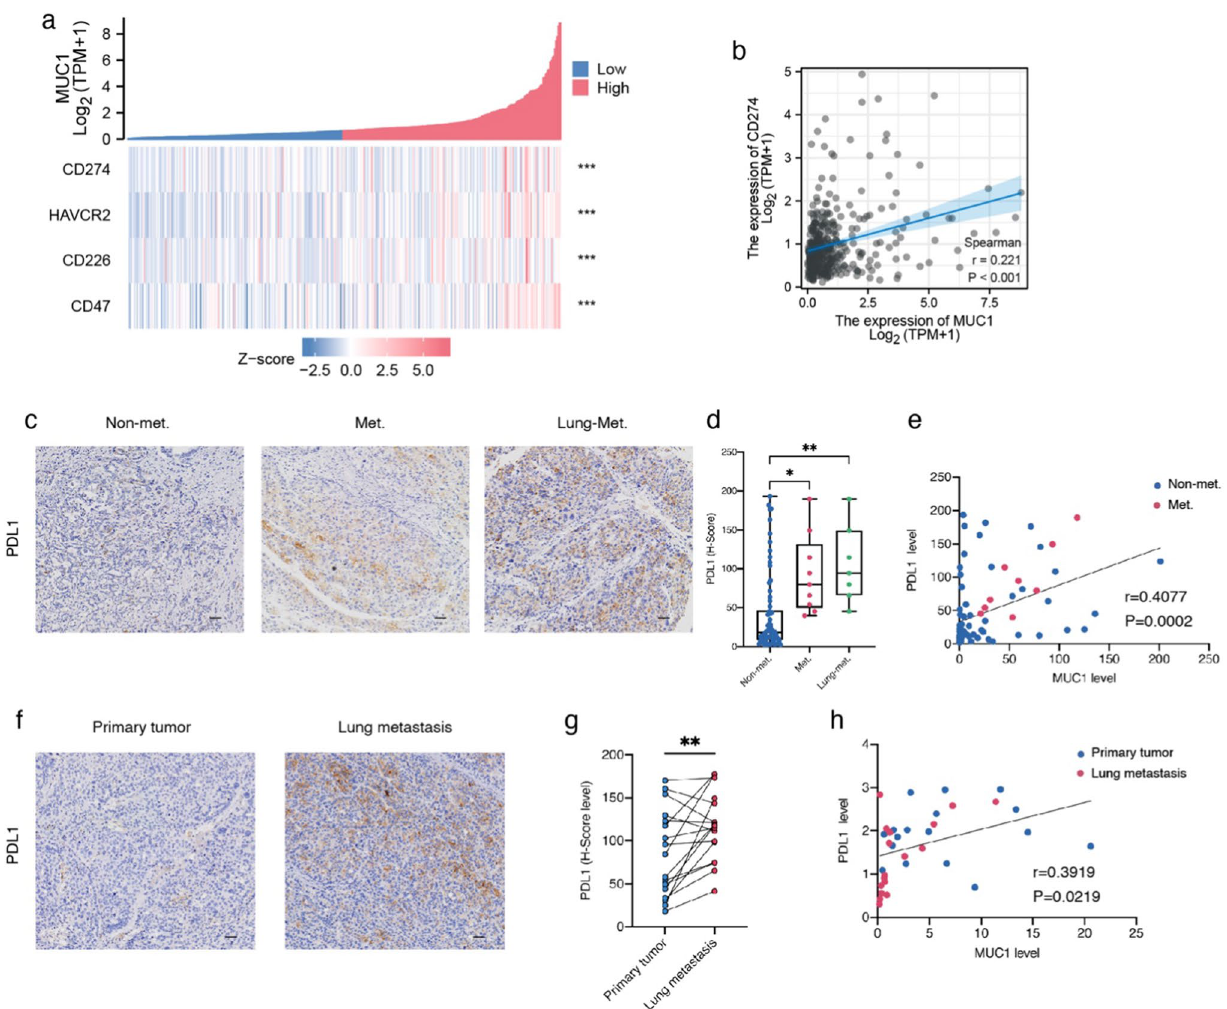
Fig. 5 Correlation of MUC1 with immune checkpoints in tumor immune microenvironment. a , b Correlation analysis of MUC1 expression with immune checkpoints in LIHC of TCGA. c – e Analysis of MUC1 and PDL1 in HCC patients. c Representative pictures of PDL1 IHC staining. d Comparisons of PDL1 level in non-metastatic with metastatic and lung metastatic tumors. e Correlation analysis of MUC1 expression with PDL1 level. f – h Analysis of MUC1 and PDL1 in primary and lung metastatic tumors from the same patient. f Representative pictures of PDL1 IHC staining. g Comparisons of PDL1 level in primary and lung metastatic tumors from the same patient. h Correlation analysis of MUC1 expression with PDL1 level. Scale bars, 50 μm. *P < 0.05, **P < 0.01, ***P < 0.001, by two-tailed unpaired or paired t test ( d , g ) and Pearson correlation analysis ( b , e and h